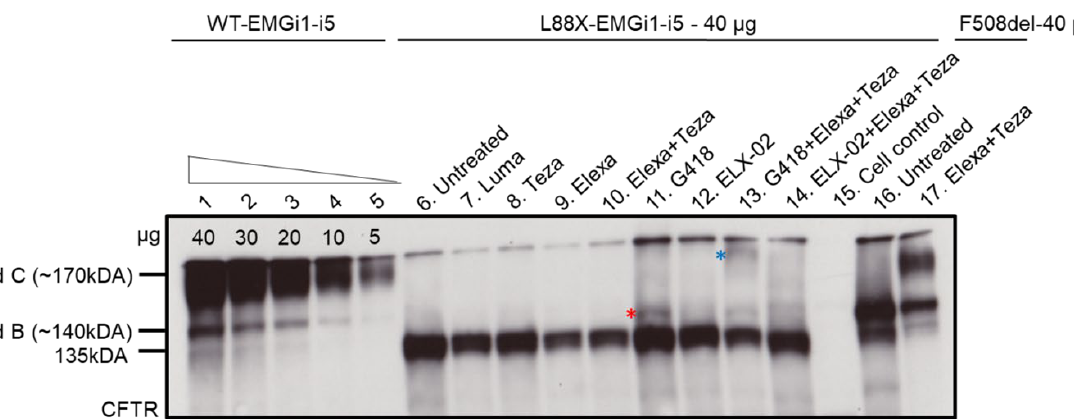
Figure 2. Readthrough and CFTR modulator combination restores full-length, mature, complex- glycosylated CFTR protein for variant L88X. Immunoblot showing steady state levels of immature, core-glycosylated CFTR protein (band B) and mature, complex-glycosylated CFTR protein (band C). Protein lysates were collected from stably transfected HEK293 cells expressing L88X- CFTR -EMGi1-i5 to show response to CFTR modulators (lumacaftor 3 μM, tezacaftor 3 μM, and elexacaftor 3 μM), readthrough (G418 200 μM, ELX-02 50 μM), or their combination. All treatments were given for 24 h. μg corresponds to the amount of protein loaded. Triangle indicates decreasing amounts of WT-EMGi1-i5 protein loaded, as indicated by respective labels. Red asterisk indicates full-length core-glycosylated CFTR, and blue asterisk indicates full-length, mature, complex-glycosylated CFTR. HEK293 cells expressing WT- CFTR -EMGi1-i5 and intronless F508del CFTR served as positive controls, and non-transfected HEK293 cells as a negative control (cell control). Immunoblot was probed with anti-CFTR antibody, 596.